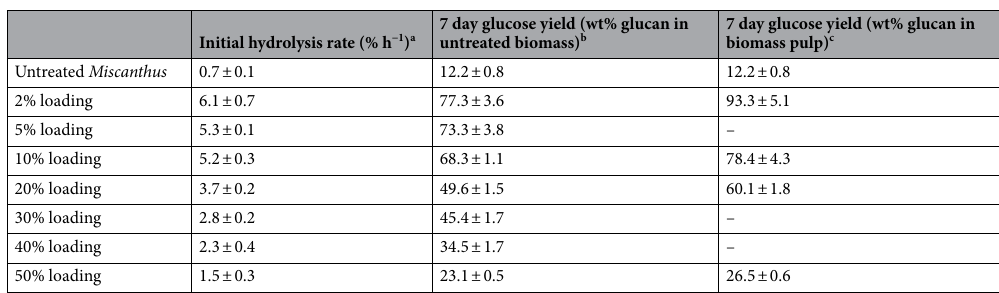
Table 1. Initial glucose release after 2 h and final glucose release after 7 days of hydrolysis. a Initial hydrolysis rate determined as glucose released after first 2 h of hydrolysis. b ,c Final glucose release after 7 day is expressed as two different percentages of glucose release: (b) relative to untreated biomass, and (c) relative to pretreated